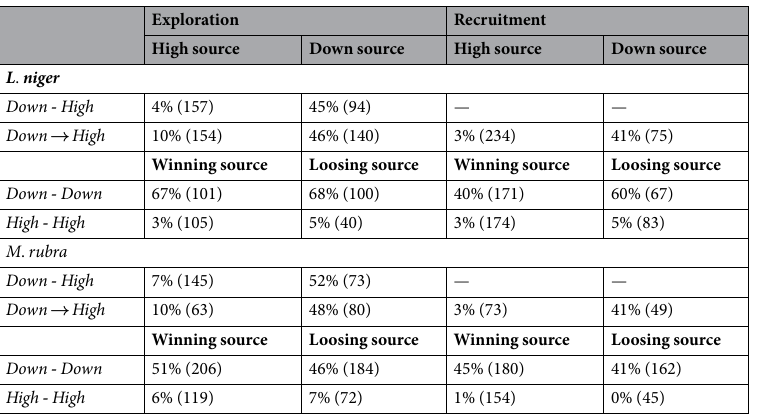
Table 4. U-turn rates on ascendant and descendant branches towards the food sources in different conditions. The U-turn rate was measured in all experimental conditions for the two studied species. For the Down- Down and High-High control conditions, values were counted for both left and right sources and classified as “winning” and “losing”